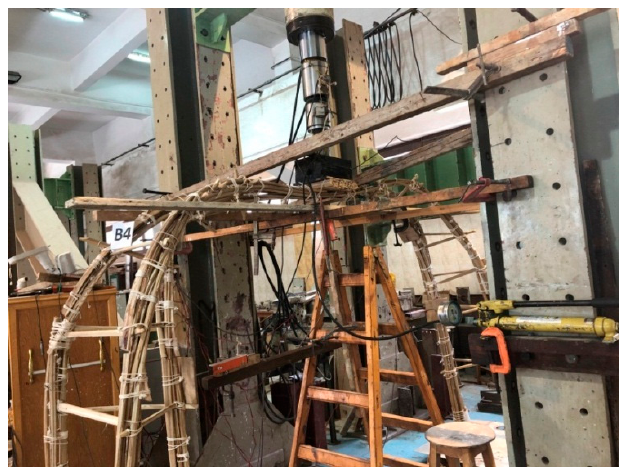
Figure 19. The middle of the top of the specimen is pushed below the rest of the flattened area after failure and before releasing the loading jack.